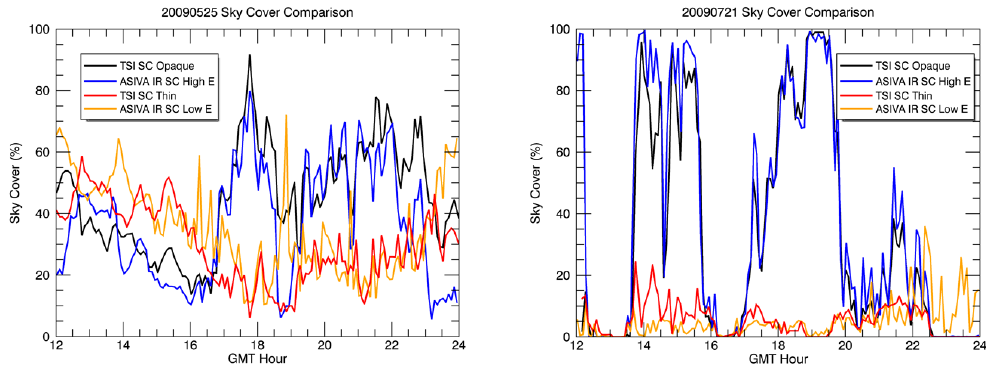
Fig. 7. (a) Sky cover comparisons between TSI (thin and opaque) and ASIVA IR (low and high emission) during daylight hours on Figure 7. a) Sky cover comparisons between TSI (thin and opaque) and ASIVA IR (low and 2 25 May 2009 for threshold values 0.15 < low emission < 0.05 and high emission ≥ 0.05, and (b) on 21 July 2009 for threshold values 0.03 < low emission < 0.05 and high emission ≥ 0.05. high emission) during daylight hours on May 25, 2009 for threshold values 0.15 < low 3 emission < 0.05 and high emission ≥ 0.05 and b) on July 21, 2009 for threshold values 0.03 < 4 low emission < 0.05 and high emission ≥ 0.05. 5